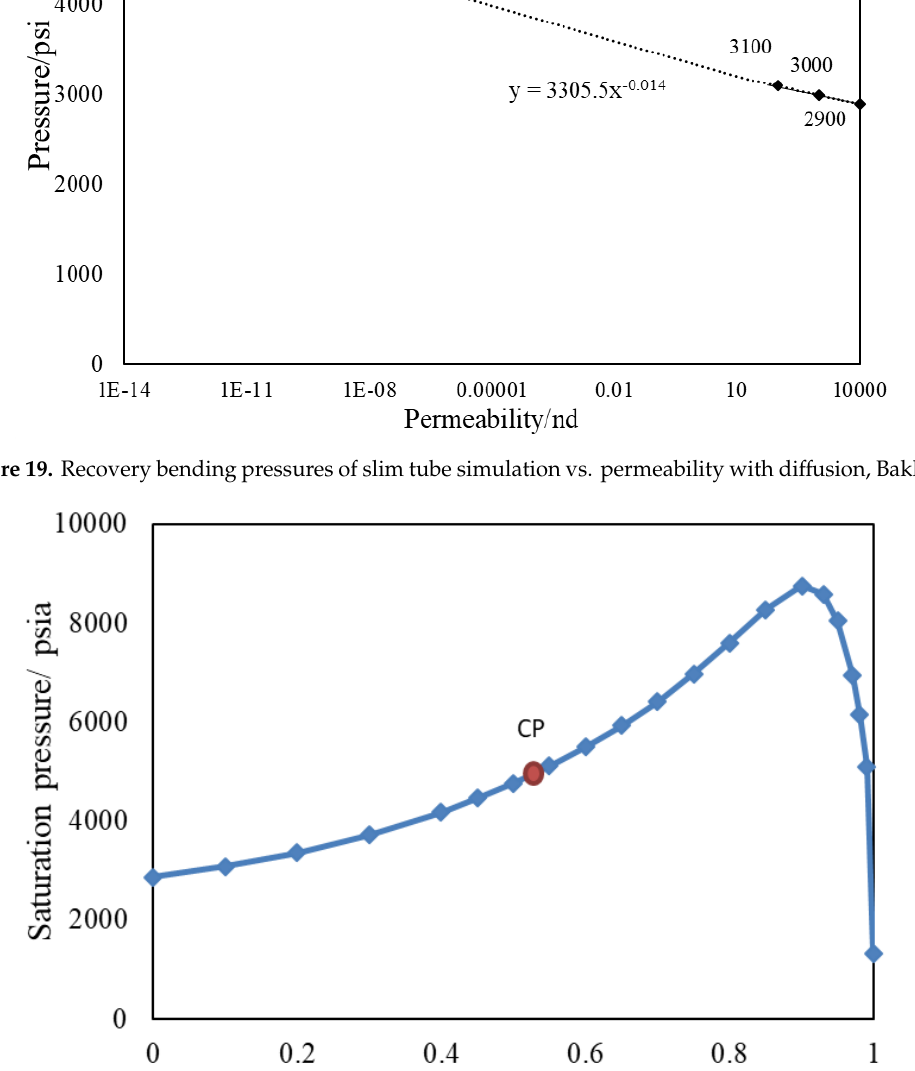
Figure 20. Swelling test for Bakken-CO 2 fluid.